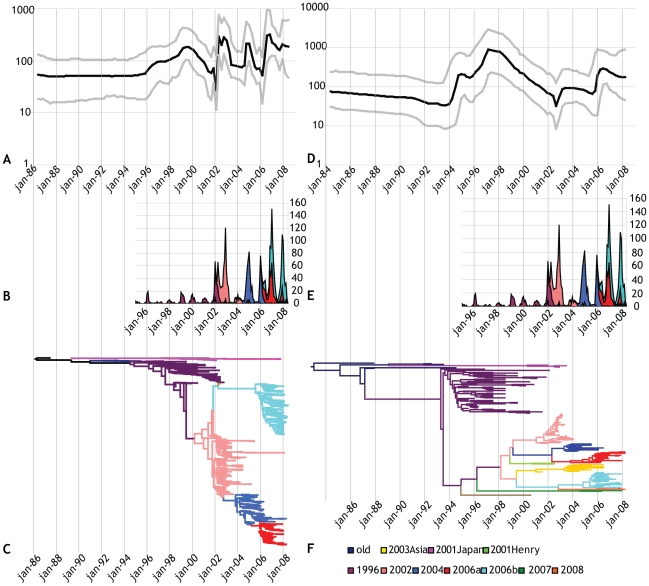
Phylodynamics of the GII.4 noroviruses.The left panel (A, B, C) describes analysis of the polymerase dataset, the right panel (D, E, F) the analysis of the capsid dataset. A) Bayesian Skyline Plot (BSP) of GII.4 NoV partial polymerase sequences, representing the relative genetic diversity, a measure for the number of effective infections, of circulating GII.4 NoVs through time. The black line represents the median posterior value, the grey lines the 95% Highest Probability Density (HPD) intervals. The Y-axis depicts the value of Neτ on a logarithmic scale. B and E) Surveillance data of NoV GII.4 strains, detected in outbreaks, included for comparison. Only European surveillance data was obtained from the FBVE database and from Dutch surveillance [12], [13]. The different GII.4 variants detected in the outbreaks are represented by different colors, showing the displacement of subsequent variants through time. The same colors were used in panels D and F, the color legend is shown under panel F. C) Maximum Clade Credibility (MCC) Tree of NoV GII.4 partial polymerase dataset. The MCC tree represents an estimate of the posterior distribution of tree topologies and branch lengths. Different variants are represented in different colors, the tree is scaled in units of time with tips constrained to strain detection dates. D) BSP of the GII.4 NoV capsid dataset. F) MCC tree of the GII.4 NoV capsid dataset.